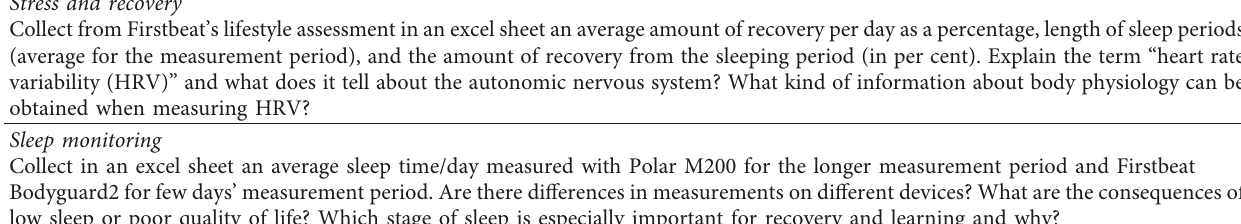
Table 1: Five examples of the course tasks.